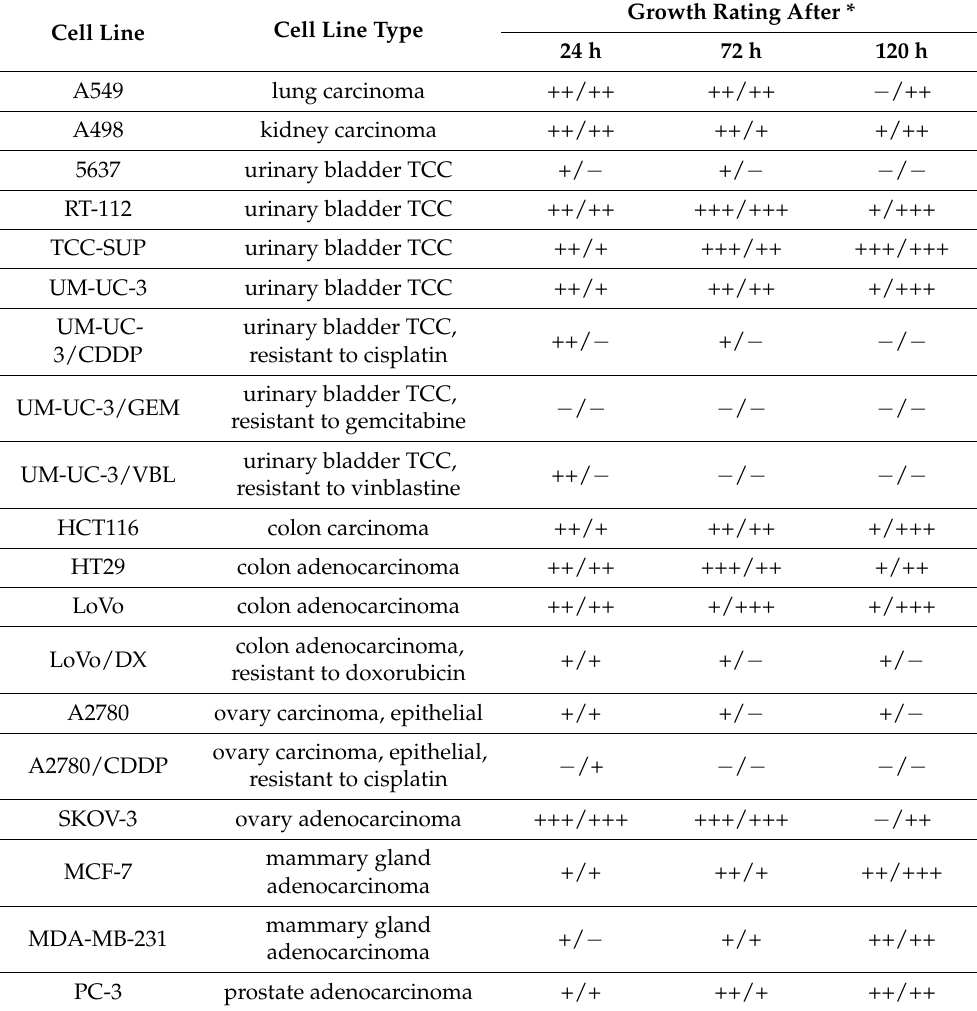
Table 4. Characteristics of cancer cell growth (proliferation) on the LOC platform using a standard (cell line-optimized) culture